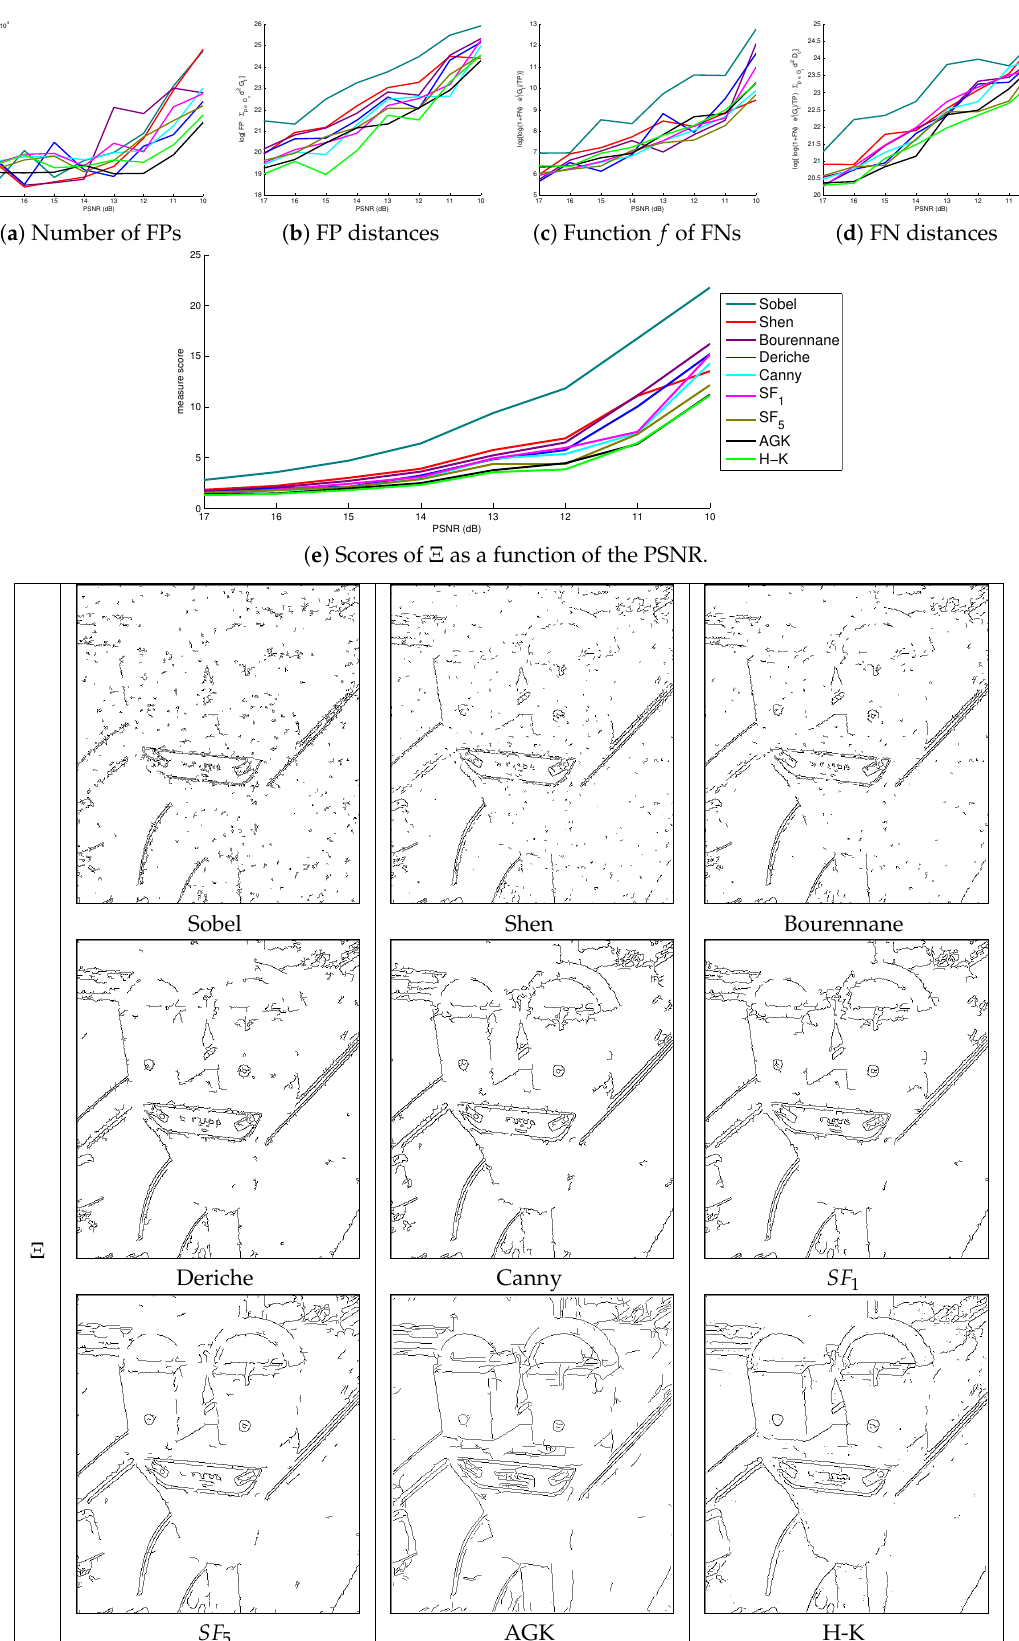
Figure 49. Segmentations and scores concerning Ξ measure and image